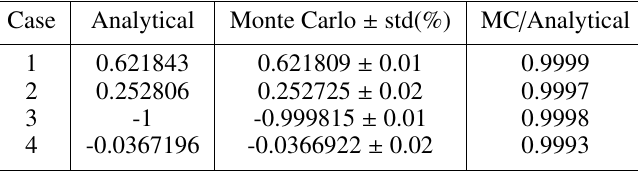
Table 1: Infinite medium model. Time-eigenvalues α as computed by Monte Carlo using the super-history method, for a few configurations.